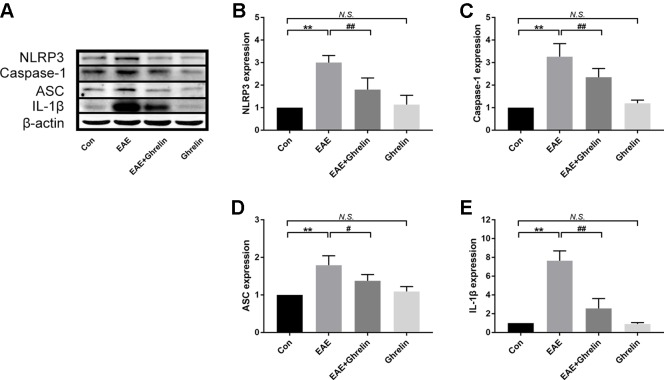
Treatment of ghrelin inhibited the NLRP3 signaling pathway in EAE rats. (A) Representative western blot images of changes in the expression level of NLRP3, ASC, caspase-1, and IL-1β. (B–E) β-Actin was used as internal control to calculate relative expression. Data were shown as mean ± SD (n = 5). **P 0.01 versus the control group, #
P 0.05,##
P 0.01 versus the EAE group. NS, not significant. Con, control.